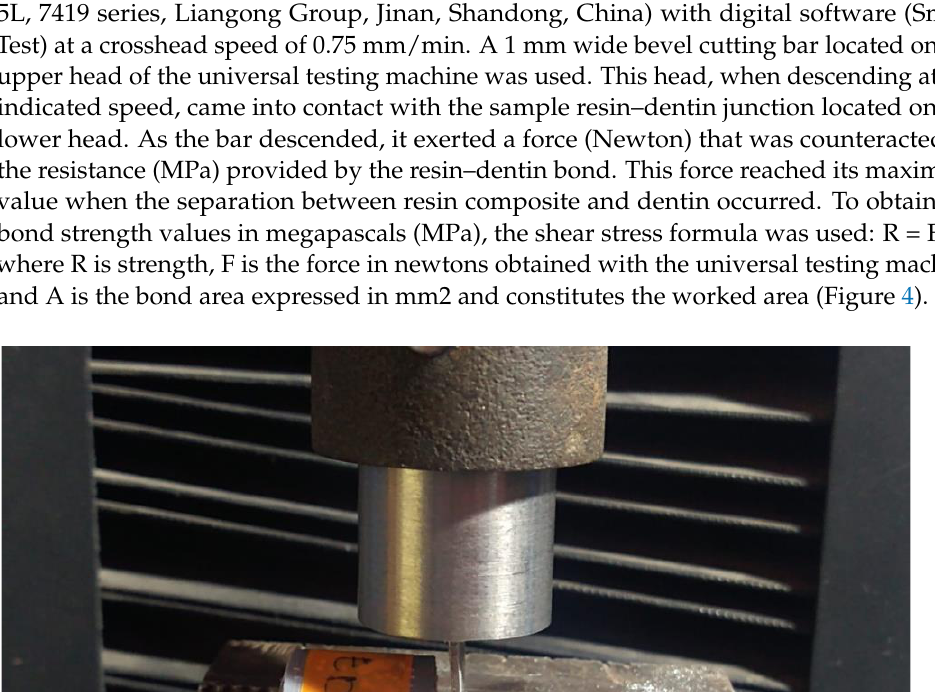
Figure 3. Light curing of Bulk-Fill resin blocks with LED unit.